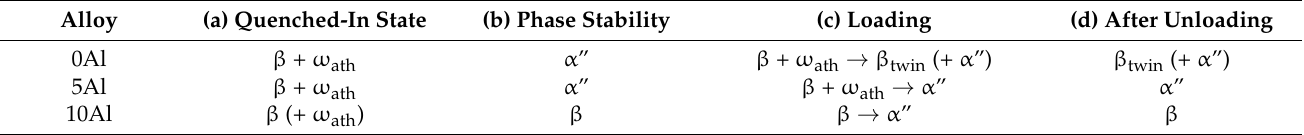
Figure 5. Illustrations of the effect of Al concentration on ( a ) phase stability during loading w/ ω ath phase, ( b ) phase stability during unloading w/o ω ath phase, and ( c ) stress hysteresis of Ti-6Mo-Al alloys. Table 1. The phase constituents and phase transformations at (a) quenched-in, (b) intrinsically stable (w/o ω ath phase), (c) loading w/ ω ath phase, and (d) unloading w/o ω ath phase states.